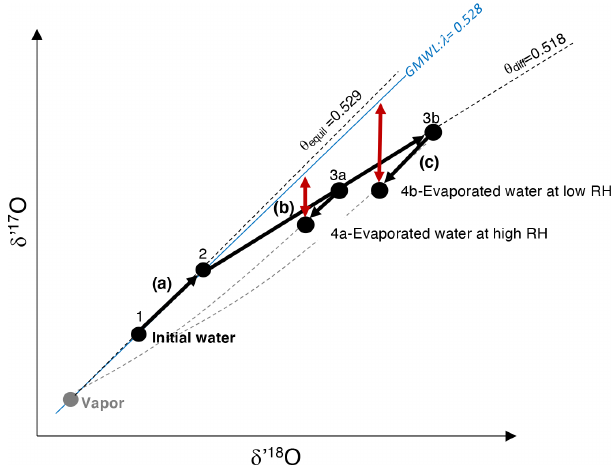
Figure 1. Representation of the three fractionating processes that interplay in the leaf boundary layer during evaporation, as conceptu- alized by the Craig and Gordon model: (a) from 1 to 2: equilibrium fractionation between initial water (unevaporated) and atmospheric vapor; (b) from 2 to 3a or 3b: fractionation due to vapor diffusion in humid (3a) or dry air (3b); (c) from 3a to 4a and 3b to 4b: fraction- ation due to exchange between evaporated water and atmospheric water vapor at high (3a to 4a) and low (3b to 4b) relative humid- ity. Red arrows: magnitude of the resulting 17 O excess describing the departure of d (cid:48) 17 O from a reference line with a slope λ of 0.528, equivalent to the slope of the Global Meteoric Water Line (GMWL). θ equil : slope of the equilibrium line; θ diff : slope of the diffusion line.